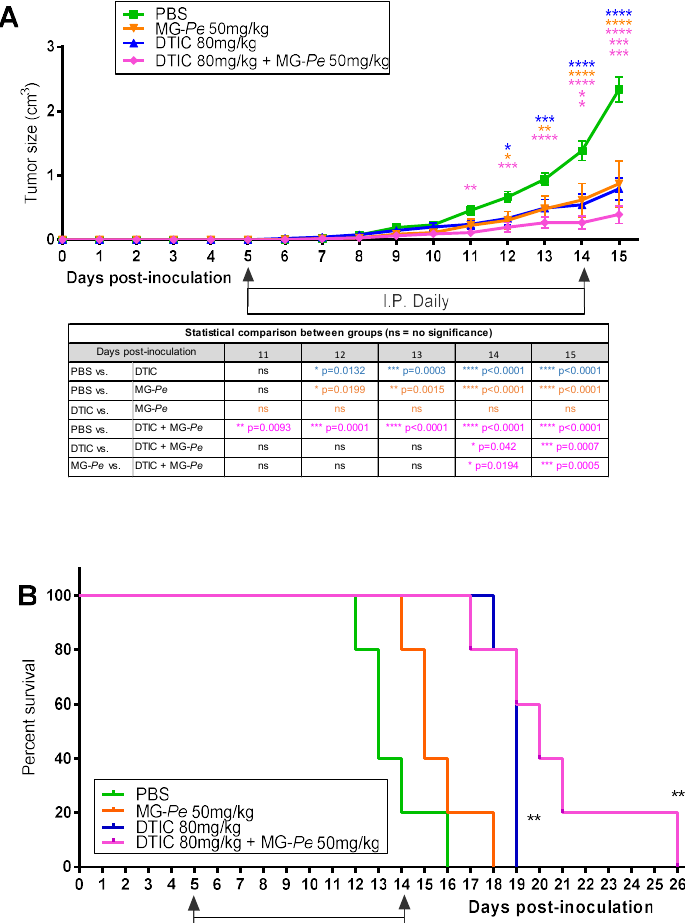
Figure 1. Partially methylated mannogalactan extracted from mushroom Pleurotus eryngii (MG- Pe ) has an adjuvant effect with Dacarbazine (DTIC) and increases animal survival. Tumor development ( A ) and survival experiment ( B ). C57BL/6 tumor bearing mice (B16-F10 cells) were I.P. daily treated for 10 days with PBS (saline control), DTIC (80 mg/kg), MG- Pe (50 mg/kg) alone, or in combination DTIC+MG- Pe (80 + 50 mg/kg). ( A ) n = 5 animals/group (mean/SEM), analyzed by two-way ANOVA test with Tukey’s post-test with multiple comparisons; ( B ) n =5 animals in each group, analyzed by survival curve test, ** p ≤